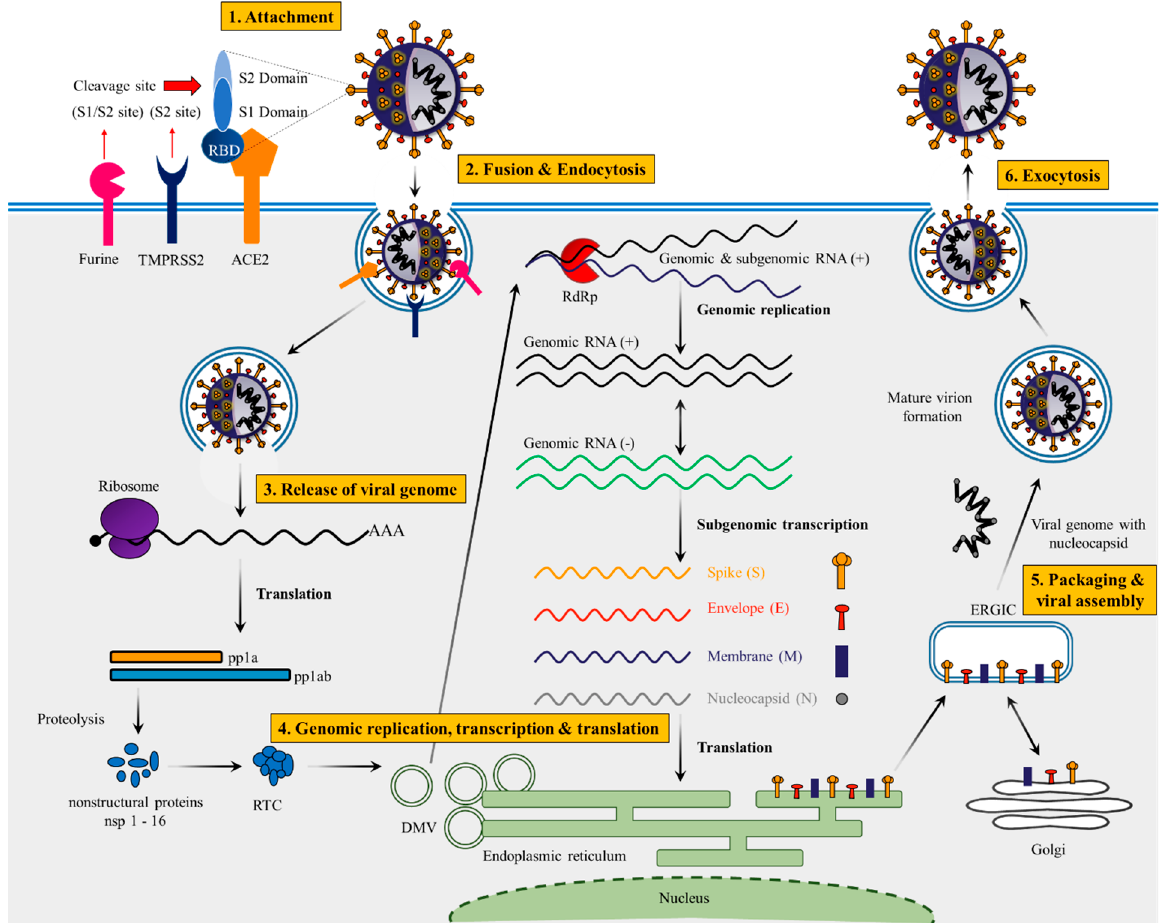
Figure 2. Complete life cycle of SARS-CoV-2. SARS-CoV-2 lifecycle begins with primary binding of the Spike protein to its specific receptors (ACE2). Mostly host cell entry depends on several steps: (i) Initial cleavage of S1/S2 specific sites by surface transmembrane protease serine-2 (TMPRSS2) and furine, (ii) followed by virus–cell membrane fusion and endocytosis. (iii) Continuing from endocytosis, m-RNA genome is mainly released into the cytosol and translated into the polyproteins. Mostly polyproteins (pp1a and pp1ab) are cleaved by specific viral-encoded protease (VEP) into the several nonstructural proteins (nsps) (mostly including RNA-dependent RNA polymerase: RdRp) which is responsible for replication transcription complex (RTC) in the cells. (iv) Viral replication begins with virus-induced double membrane vesicles mainly derived from the endoplasmic reticulum (ER). (v) Positive-strand of genome serves as a main template for full-length negative-strand RNA and sub genomic (sg)RNA and sgRNA translation results in both structural proteins and accessory proteins are inserted into the ER–Golgi intermediate compartment (ERGIC) for virion assembly, respectively. (vi) RNA genomes with specific nucleocapsid proteins are incorporated into newly synthesized virions, which are secreted by exocytosis. DMV—double-membrane vesicle.